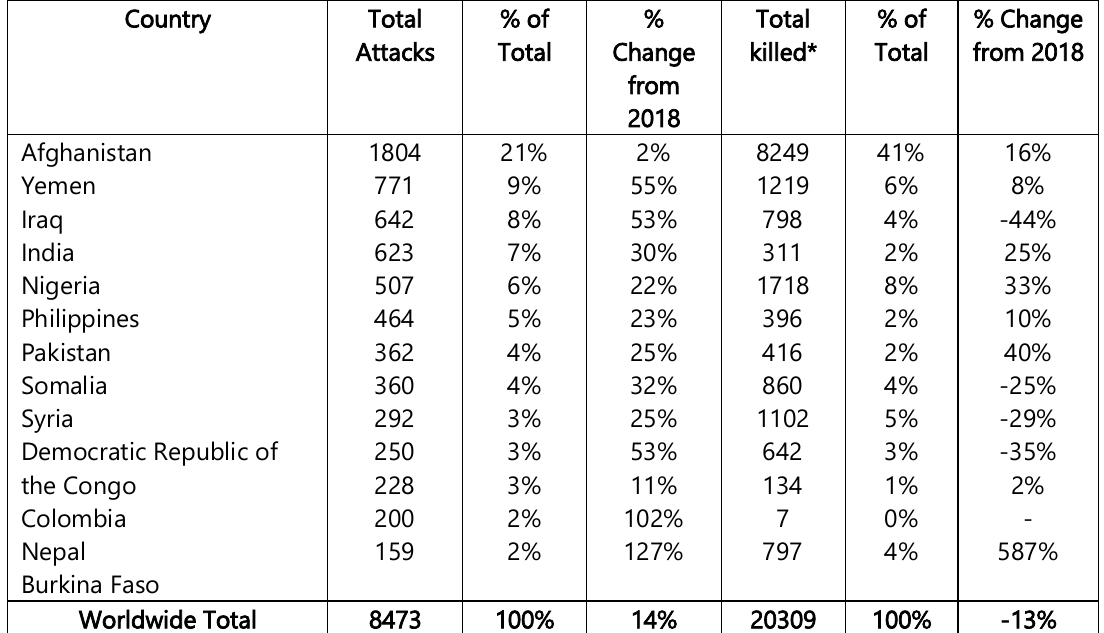
Table 1: Terrorist Attacks and Total Deaths, Countries with more than 150 Attacks, 2019 (Source: Focus Group Discussion 2022 (in Global Terrorism Database) Statistical Annex: 2020:1-2) Country